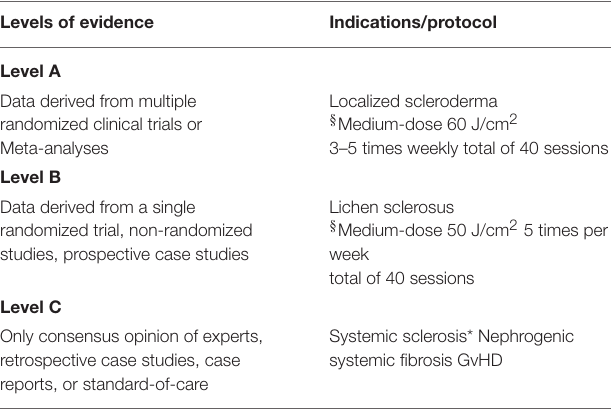
TABLE 1 | UV-A1 treatment for fibrosing conditions—levels of evidence as proposed by the American College of Cardiology and the American Heart Association